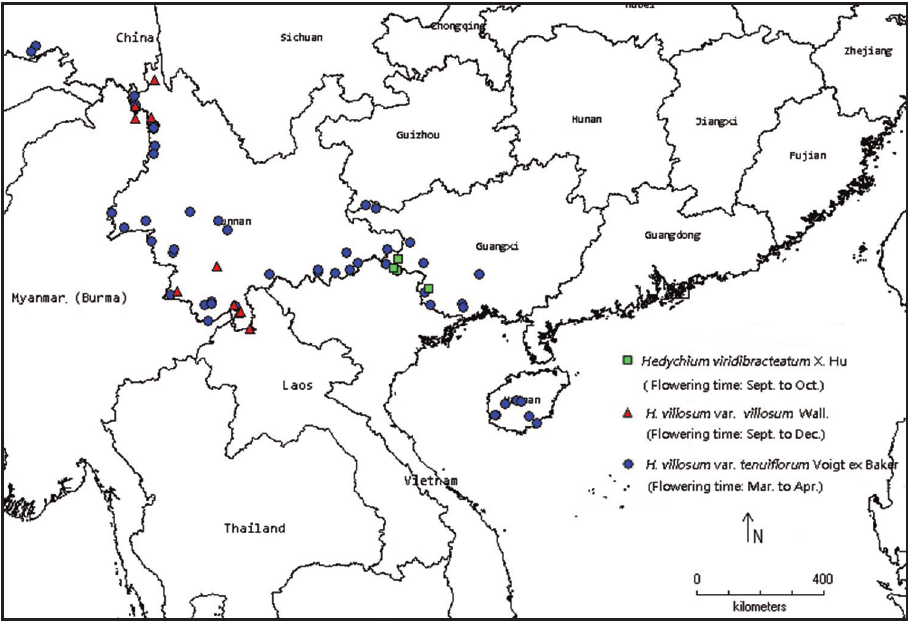
Figure 5. Distribution and flowering of Hedychium viridibracteatum X.Hu, sp. nov. and the related spe- cies H. villosum var. tenuiflorum and H. villosum var. villosum . Other Hedychium spp.